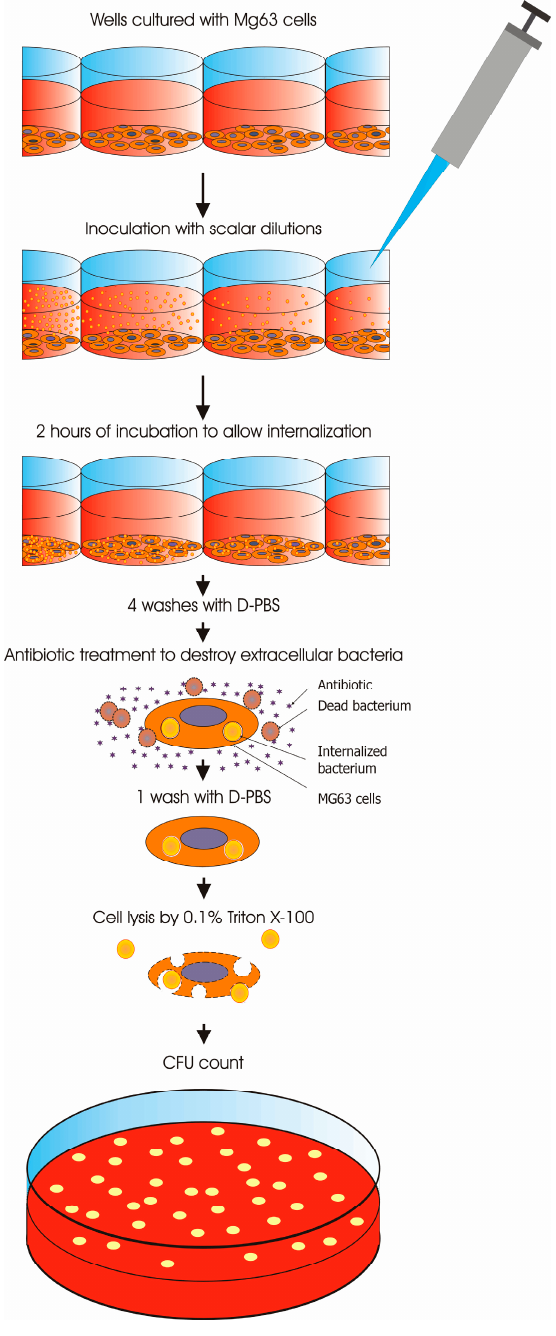
Figure 2. Gentamicin protection assay protocol utilised to assess bacterial internalization in MG63 cells.